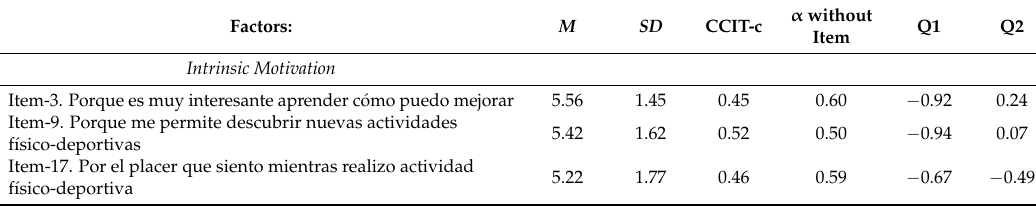
Table 1. Descriptive statistics, internal consistency and homogeneity ( n =